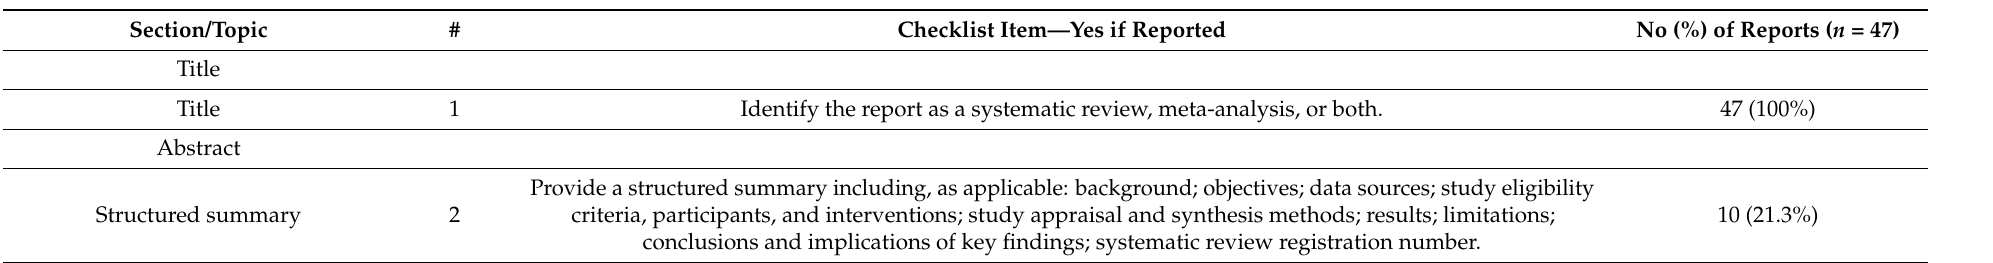
Table A2. Reporting key components of the systematic review process and meta-analyses by PRISMA